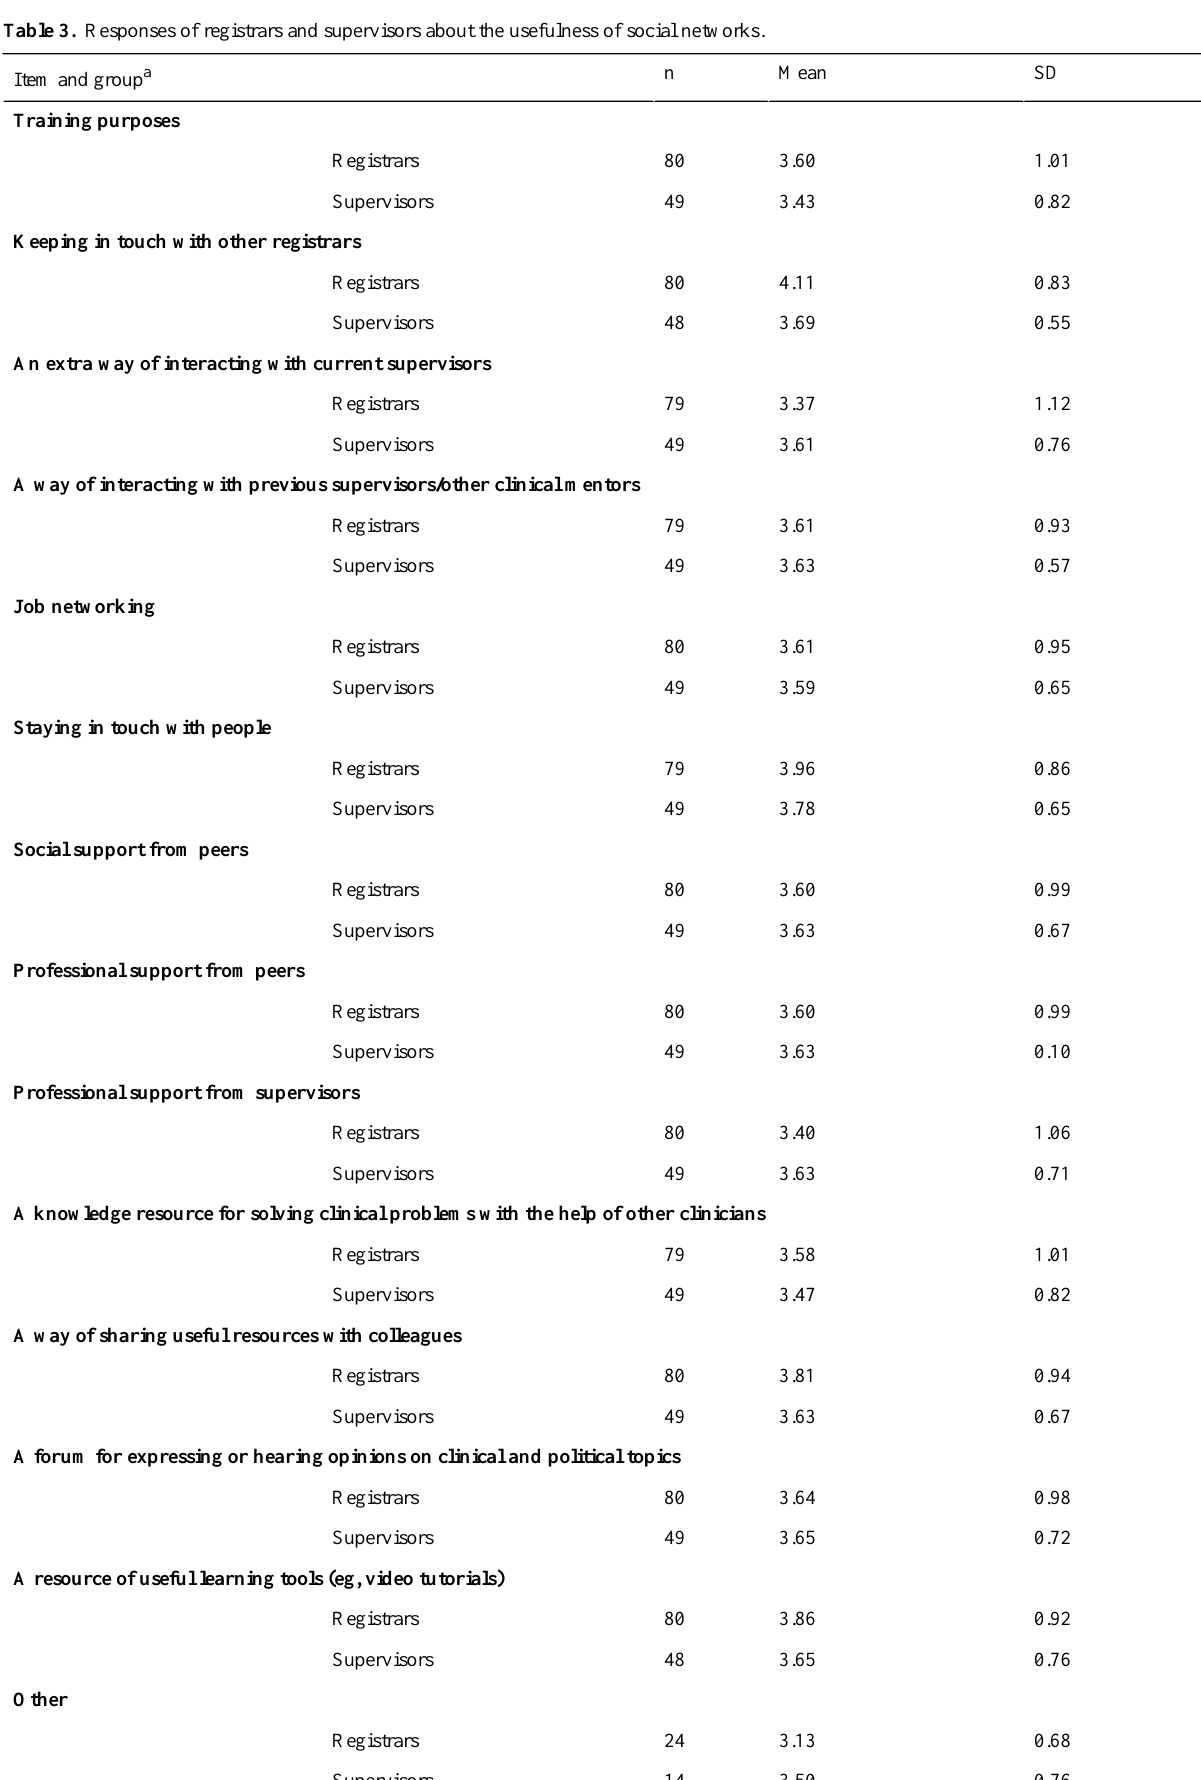
Table 3. Responses of registrars and supervisors about the usefulness of social